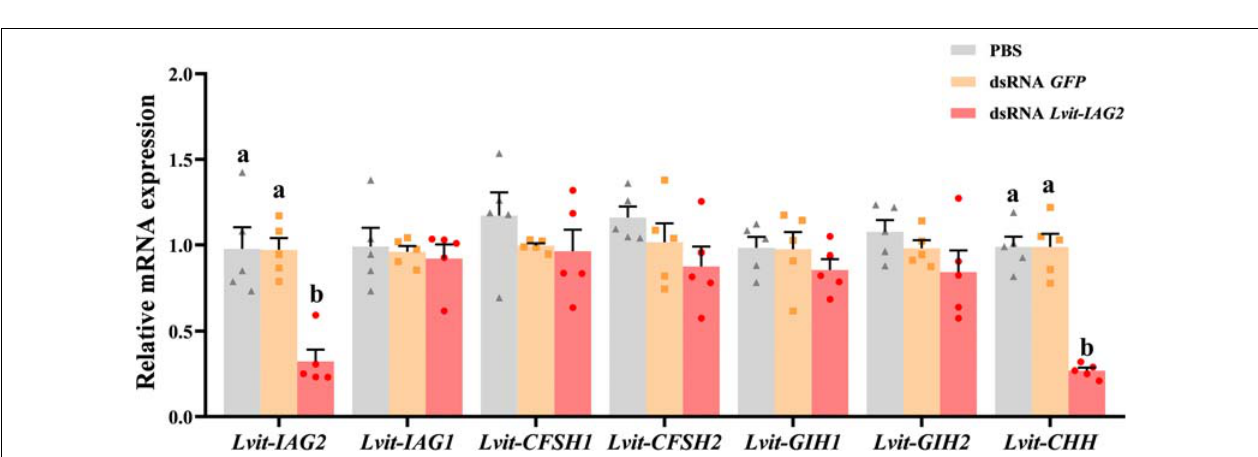
FIGURE 4 | Effects of short-term Lvit-IAG2 silencing on gene expression of L. vittata . The effectiveness of gene knockdown in the short-term Lvit-IAG2 silencing experiment was evaluated by qRT-PCR. The expression levels of Lvit-IAG2 , Lvit-IAG1 , Lvit-CFSH1 , Lvit-CFSH2 , Lvit-GIH1, Lvit-GIH2, and Lvit-CHH were detected following in vivo injection with PBS, dsRNA GFP or dsRNA Lvit-IAG2 . The gene expression levels were standardized by Lvit- β -actin expression levels and represented as mean ± SEM (“a and b,” p < 0.05; one-way ANOVA followed by Tukey’s multiple range tests; n =